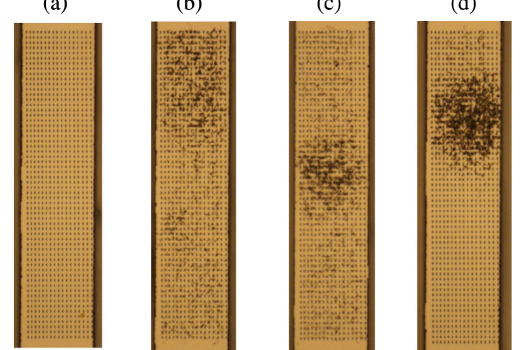
10. Example optical microscope images of single-sided MLA arrays after timed exposures of 10 7 laser shots with incident field strengths corresponding to (a) 0 (laser off), (b) 0.54, (c) 0.77, and (d) 0 . 91 GV = m, illustrating the onset and progression of